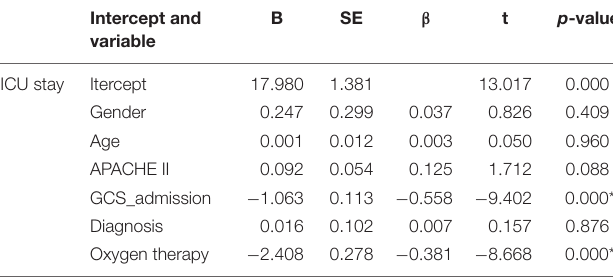
TABLE 8 | Linear regression analysis on length of ICU stay.